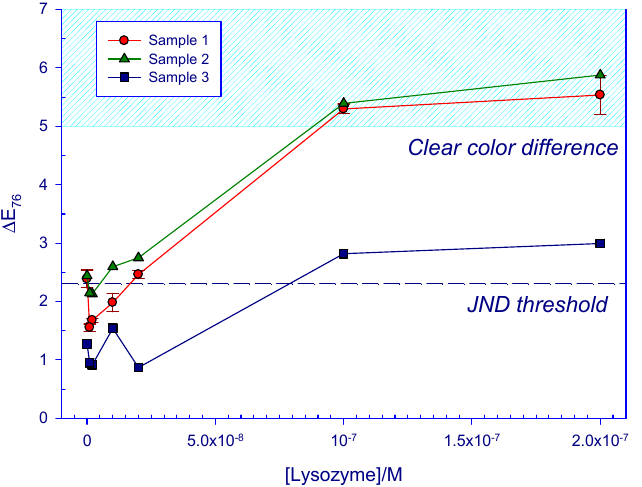
Figure 5. Sample-blank color difference Δ E 76 evolution with increasing lysozyme concentrations. Error bars, derived from repeated measurements, are shown for Sample 1.